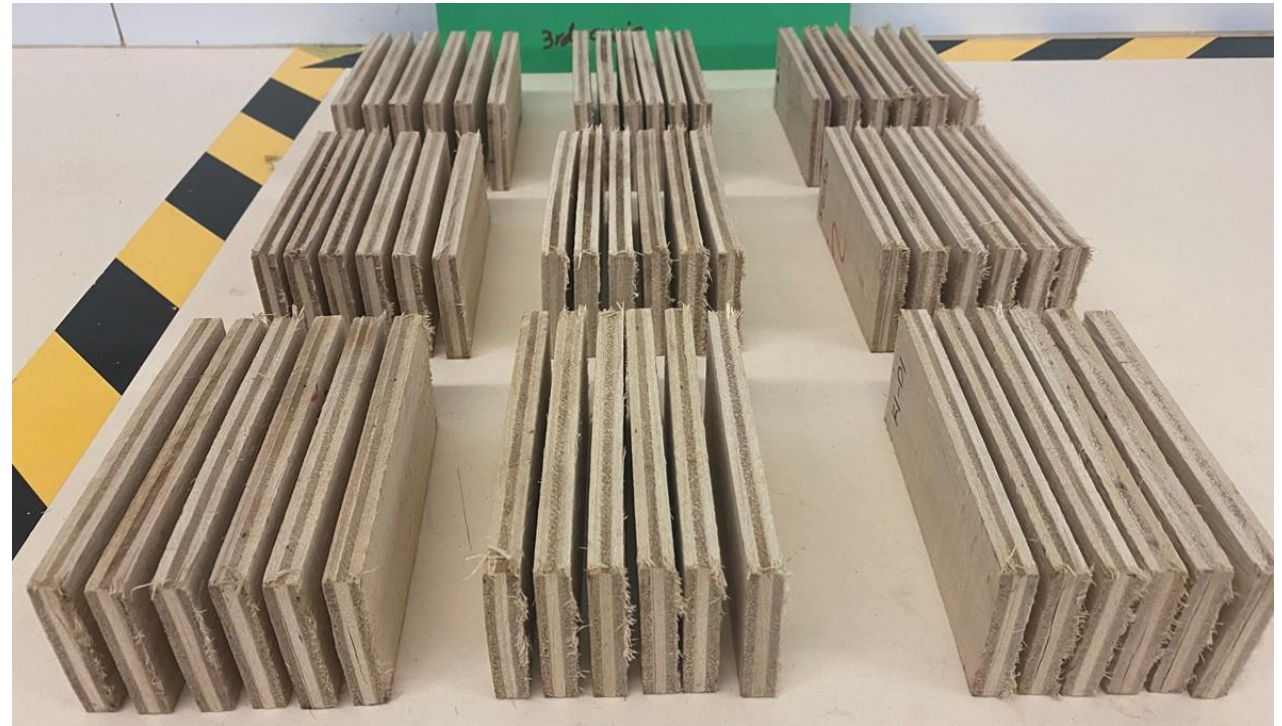
Figure 8. Plywood samples after third cycle of delamination testing according to ANSI/HPVA HP-1,